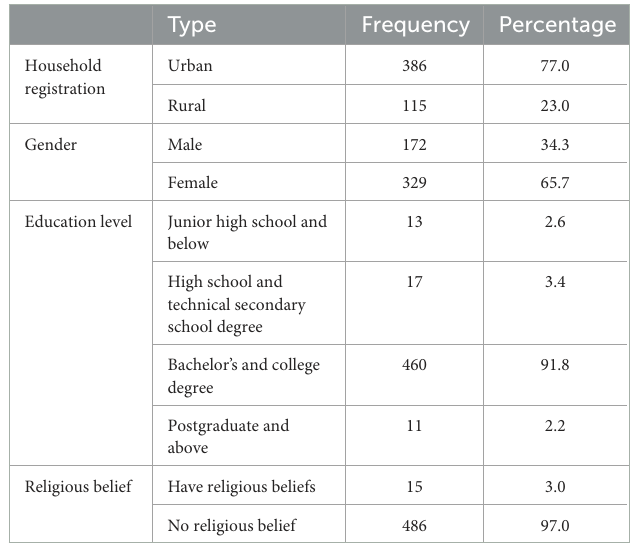
TABLE 1 Sociodemographic characteristics of respondents of the